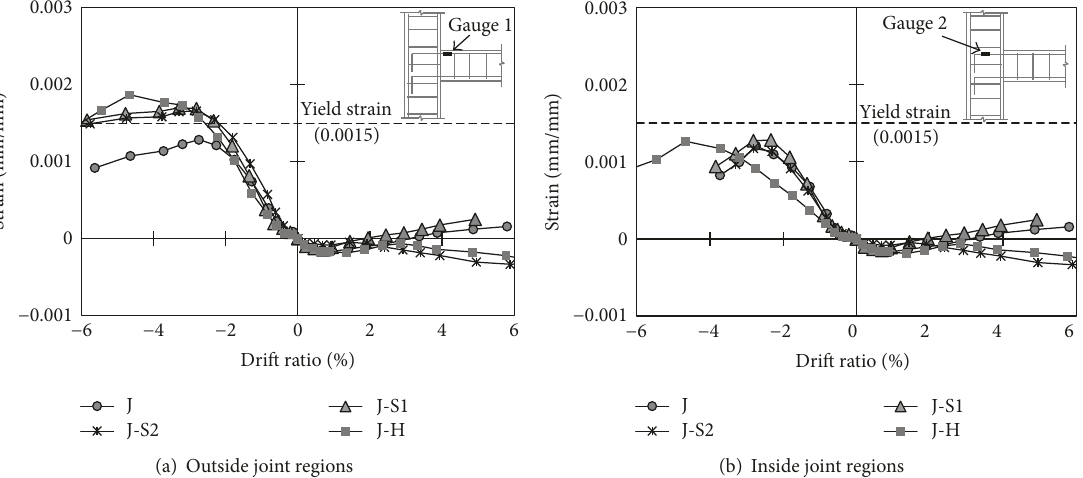
Figure 13: Strain profiles of the top rebars.